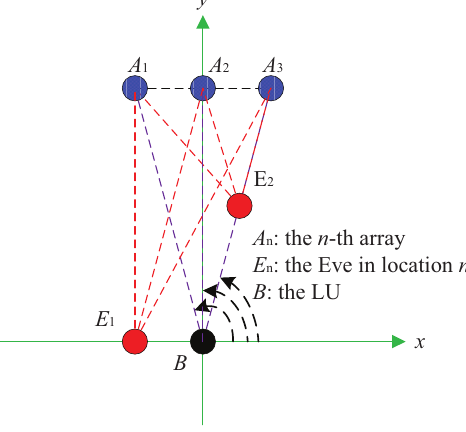
Figure 7. The locations of the LU, the potential Eve, and three transmit antenna